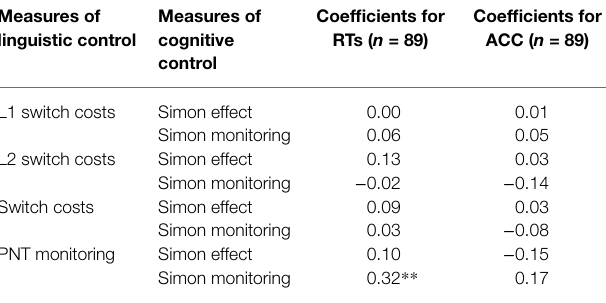
TABLE 8 | Bilinguals’ (all participants) Pearson correlations between measures of linguistic control in the picture naming task (shortened as PNT) and of cognitive control in the Simon task in terms of response times (RTs) and accuracy rates (ACC). Measures of Measures of linguistic control cognitive